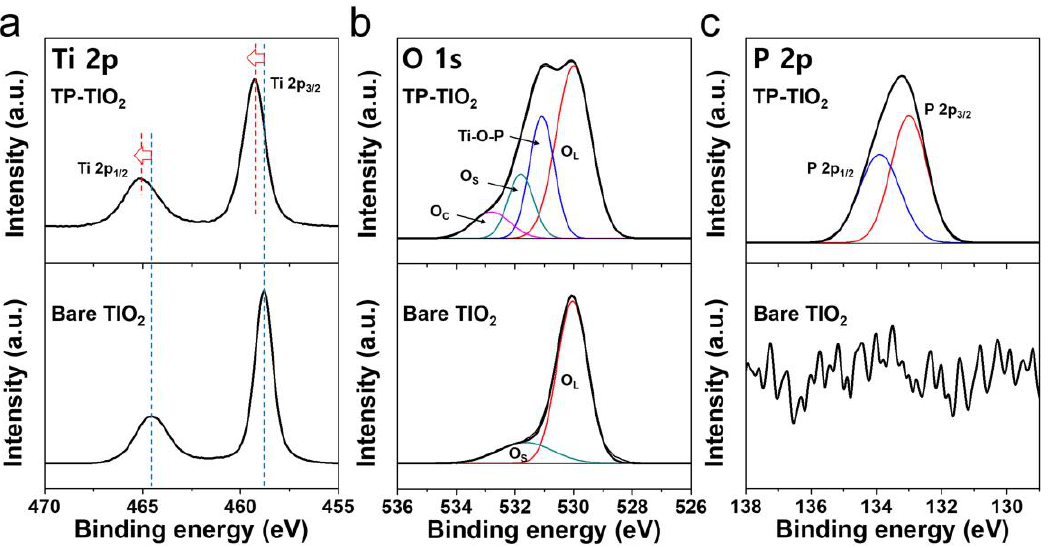
Figure 2. ( a ) Ti 2p; ( b ) O 1s; and ( c ) P 2p XPS spectra of bare and TP-TiO 2